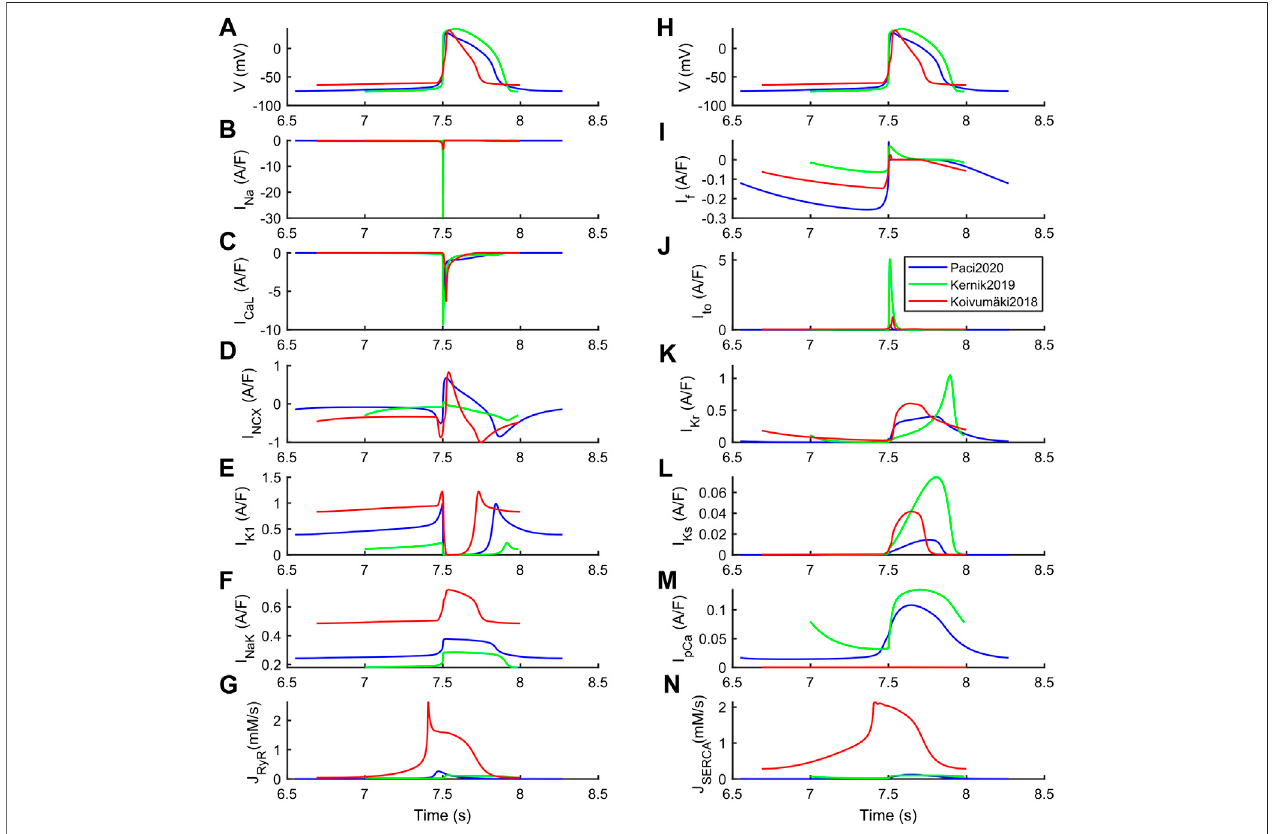
FIGURE 2 | Ion currents underlying the steady-state action potentials in the Paci2020 (blue), Kernik2019 (green) and Koivumäki2018 (red) models. (A and H) Membranepotential. (B) FastNa + current(I Na ). (C) L-typeCa 2+ current(I CaL ). (D) Na + -Ca 2+ exchanger(I NCX ). (E) InwardrectifyingK + current(I K1 ). (F) Na + -K + pump(I NaK ). (G) Ca 2+ release from sarcoplasmic reticulum (J RyR ). (I) Funny current (I f ). (J) Transient outward K + current (I to ). (K) Rapid delayed rectifying K + current (I Kr ). (L) Slow delayed rectifying K + current (I Ks ). (M) Sarcolemma Ca 2+ pump (I pCa ). (N) SERCA pump (J SERCA